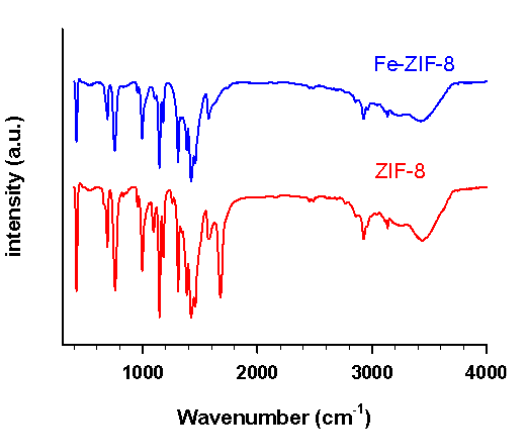
Fig. 6 FT-IR spectrum of the nanocatalysts in the range of 400– 4000 cm −1 .